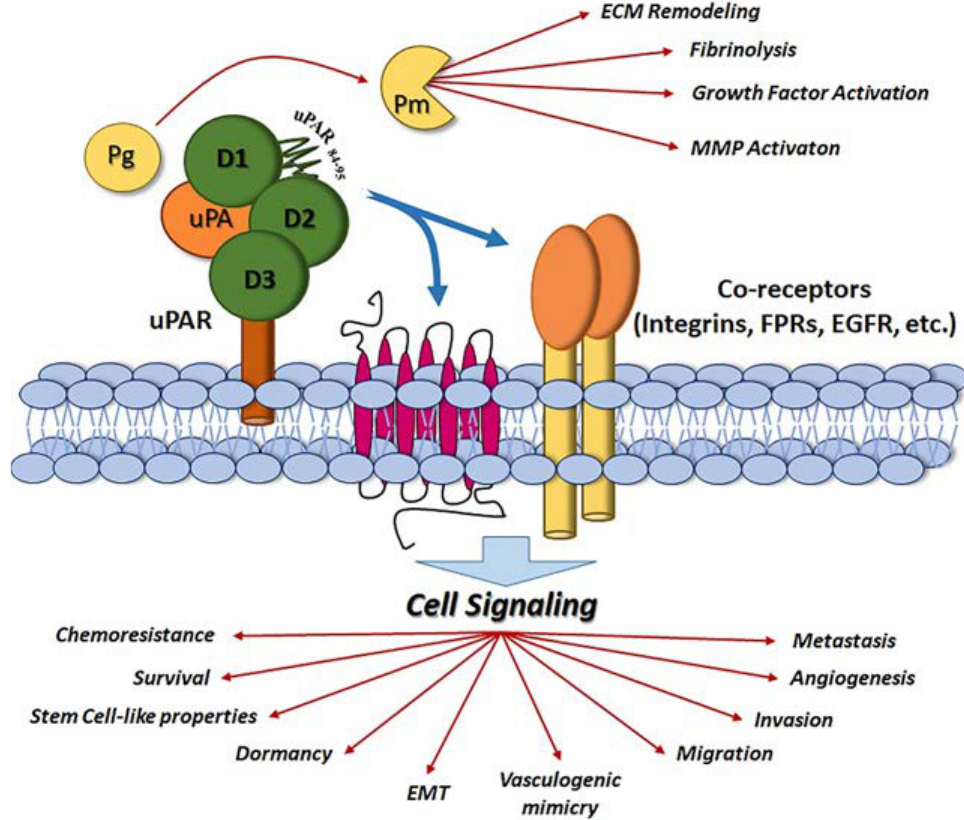
Figure 1. Schematic representation of uPA/uPAR system at cell surface. uPA binding to uPAR promotes plasminogen (Pg) activation to plasmin (Pm), which is responsible for catalytic as well as other activities in the cell nearby. uPAR co-receptors and uPAR modulated cell signaling in cancer cells are indicated (see Sections 2 and 3 for details).